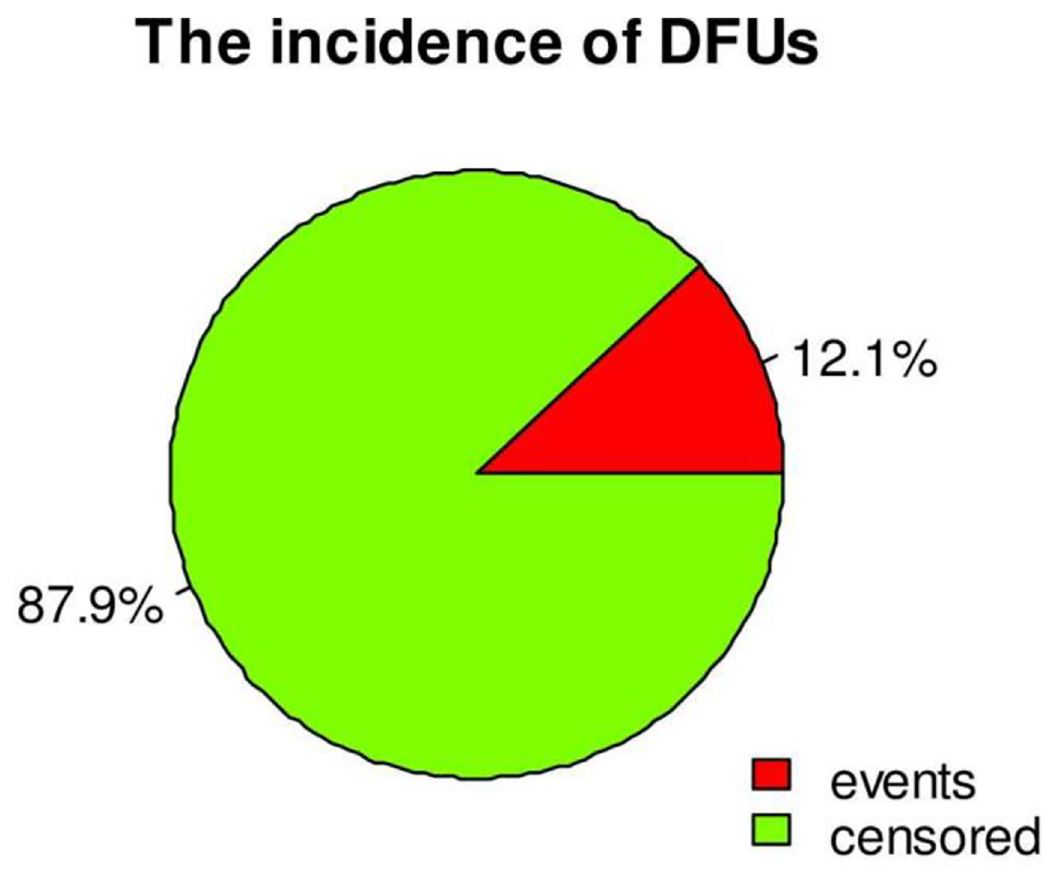
Fig 1. Incidence of DFU among DM patients on treatment at Northwest Ethiopia, from 2010 to 2020.